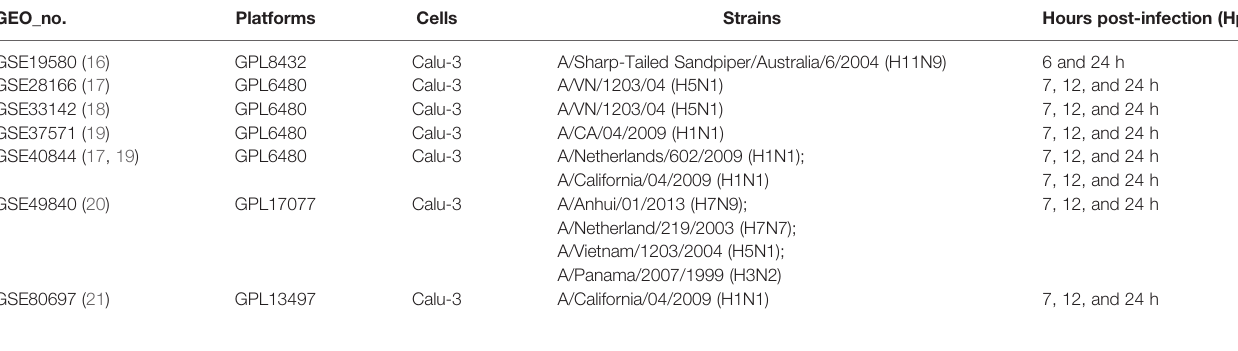
TABLE 2 | The details of gene expression pro fi les on Calu-3 cells from the GEO database.